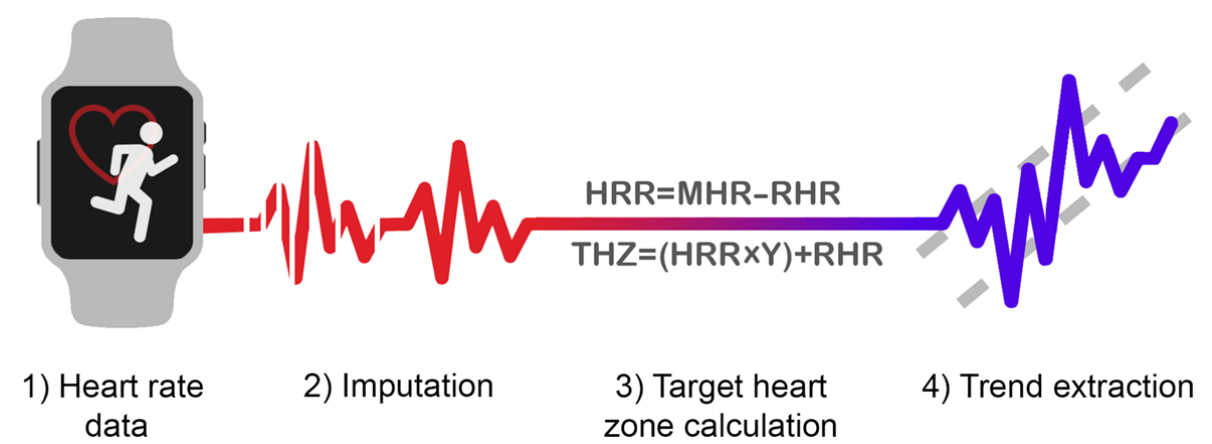
Figure 3. Overview of Physical Activity Trend eXtraction (PATX): a framework for moderate-vigorous physical activity trend extraction from raw heart rate